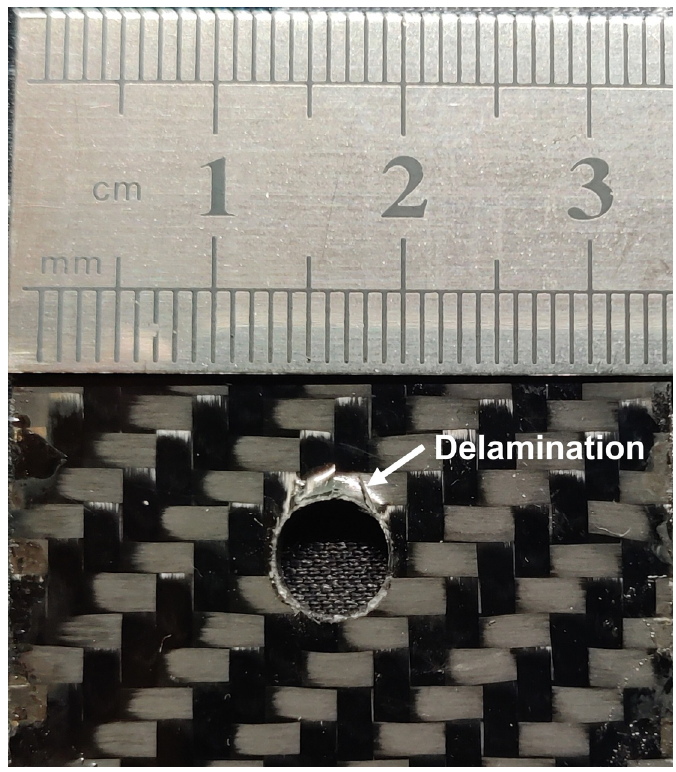
Figure 17. Mechanical drilling process induced delamination at the hole exit.